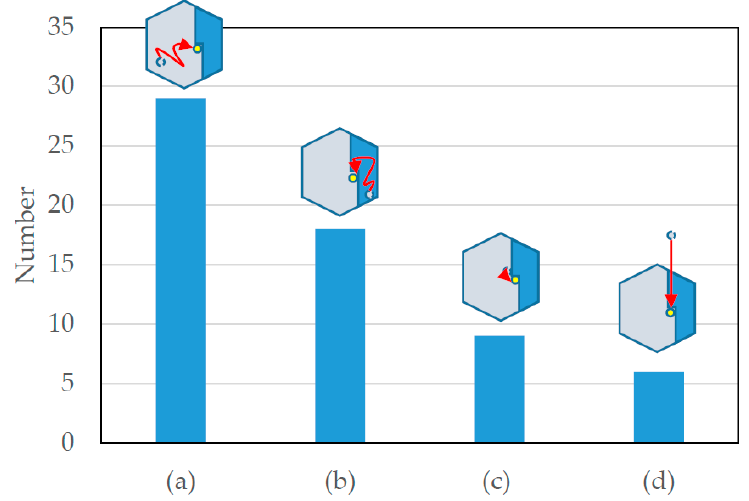
Figure 4. Number distribution of incorporation process routes. ( a ) to ( d ) indicate the same classifications described in Figure 3. At the top of bars, schematics used in Figure 3 are placed.